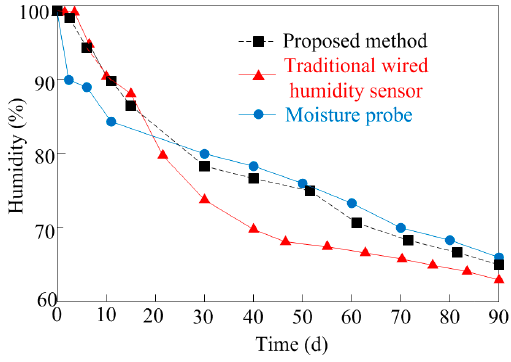
Figure 19. Performances comparison measured by different sensors.